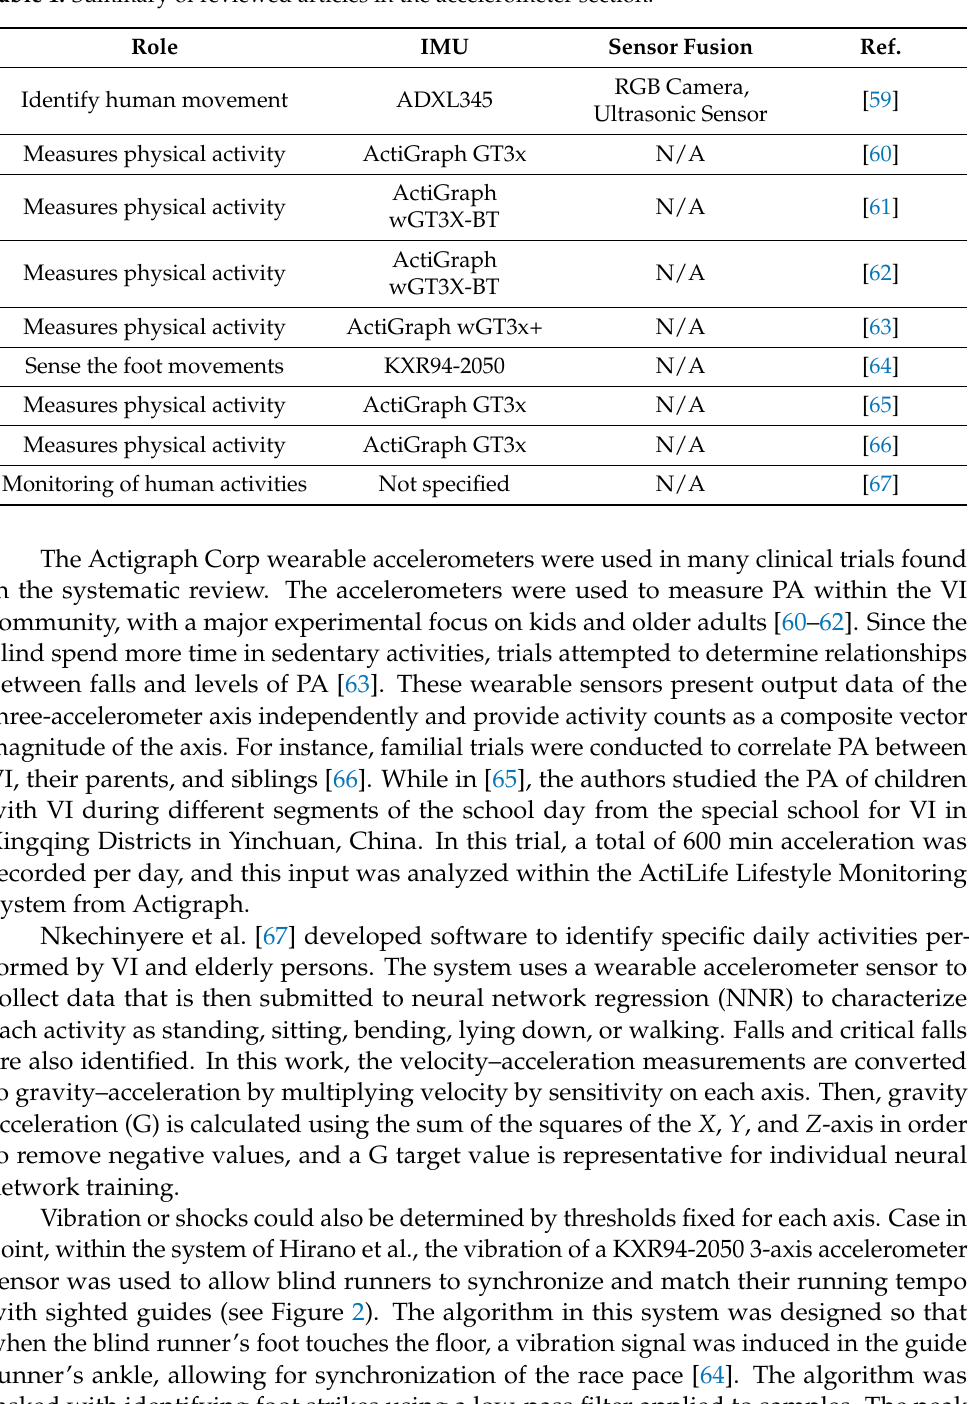
Table 1. Summary of reviewed articles in the accelerometer